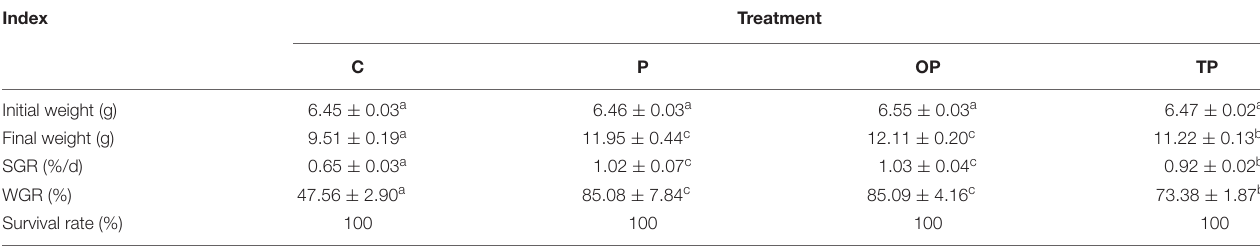
TABLE 2 | Growth performance of sea cucumbers ( Apostichopus japonicus ) fed with diets with different levels of poly- β -hydroxybutyrate (PHB).